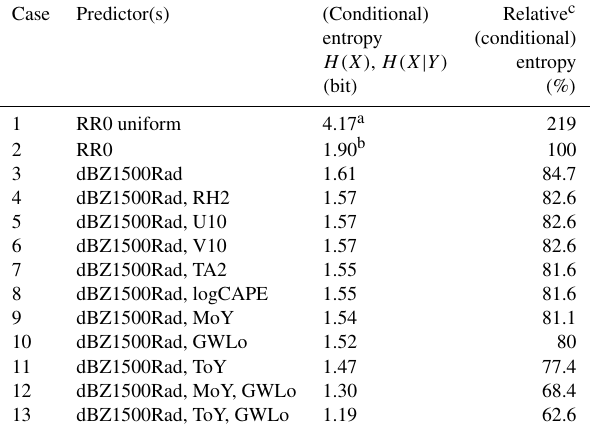
Table 2. Entropy of the target (RR0) and the benchmark distribution (RR0 uniform), conditional entropies of the target given one or sev- eral predictors, non-normalized and normalized. Underlying data are from the filtered data set. Predictors are ordered by descending conditional